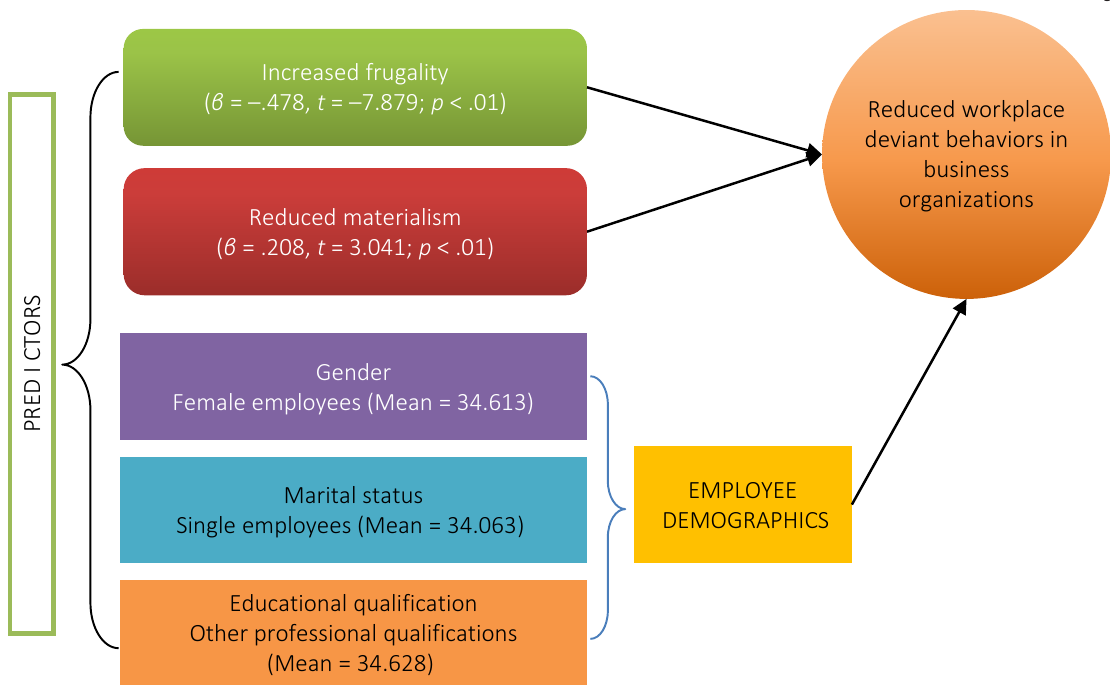
Figure 1. Practical model for reducing workplace deviant behaviors in business